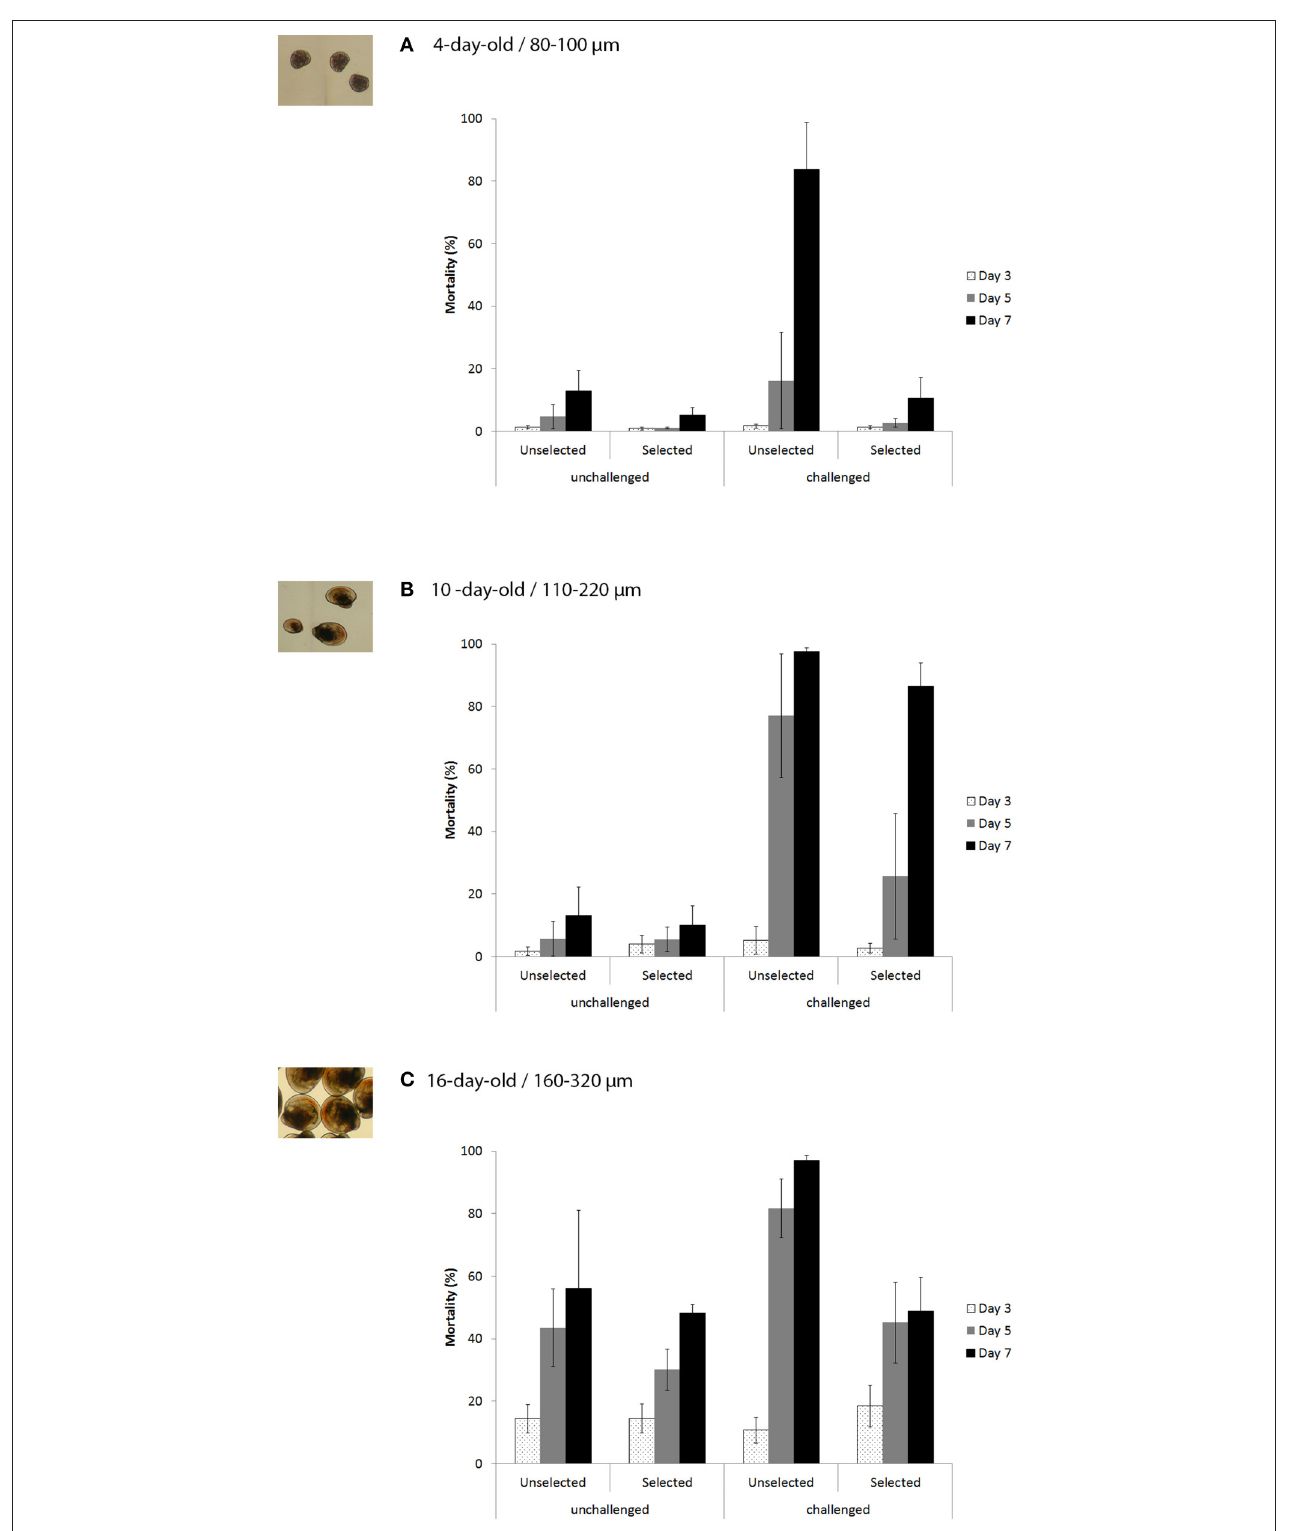
FIGURE 3 | Mortality (% ± SD) of the unselected and selected larvae on days 3, 5, and 7 post-exposure for the unchallenged and challenged conditions (10 + 6 OsHV-1 DNA copies L − 1 ) in trial 2a (A), trial 2b (B), and trial 2c (C) corresponding to 4, 10, and 17-day-old larvae, respectively and 80–100, 110–200, and 160–320 µ m larvae,